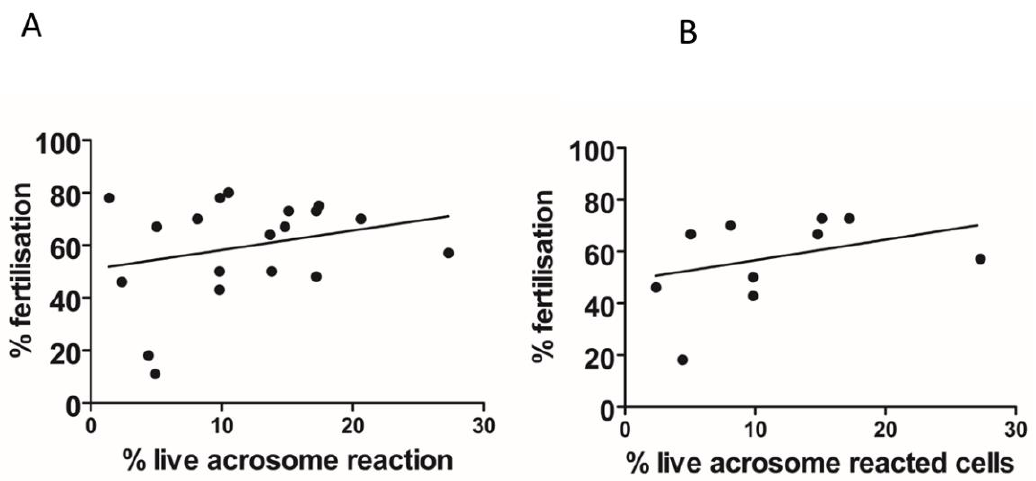
Figure 6. Relationship between the acrosome reaction triggered by P4/PGE1/NH 4 Cl and IVF success rate. ( A ). All patient data. ( B ). Couples with unexplained infertility.